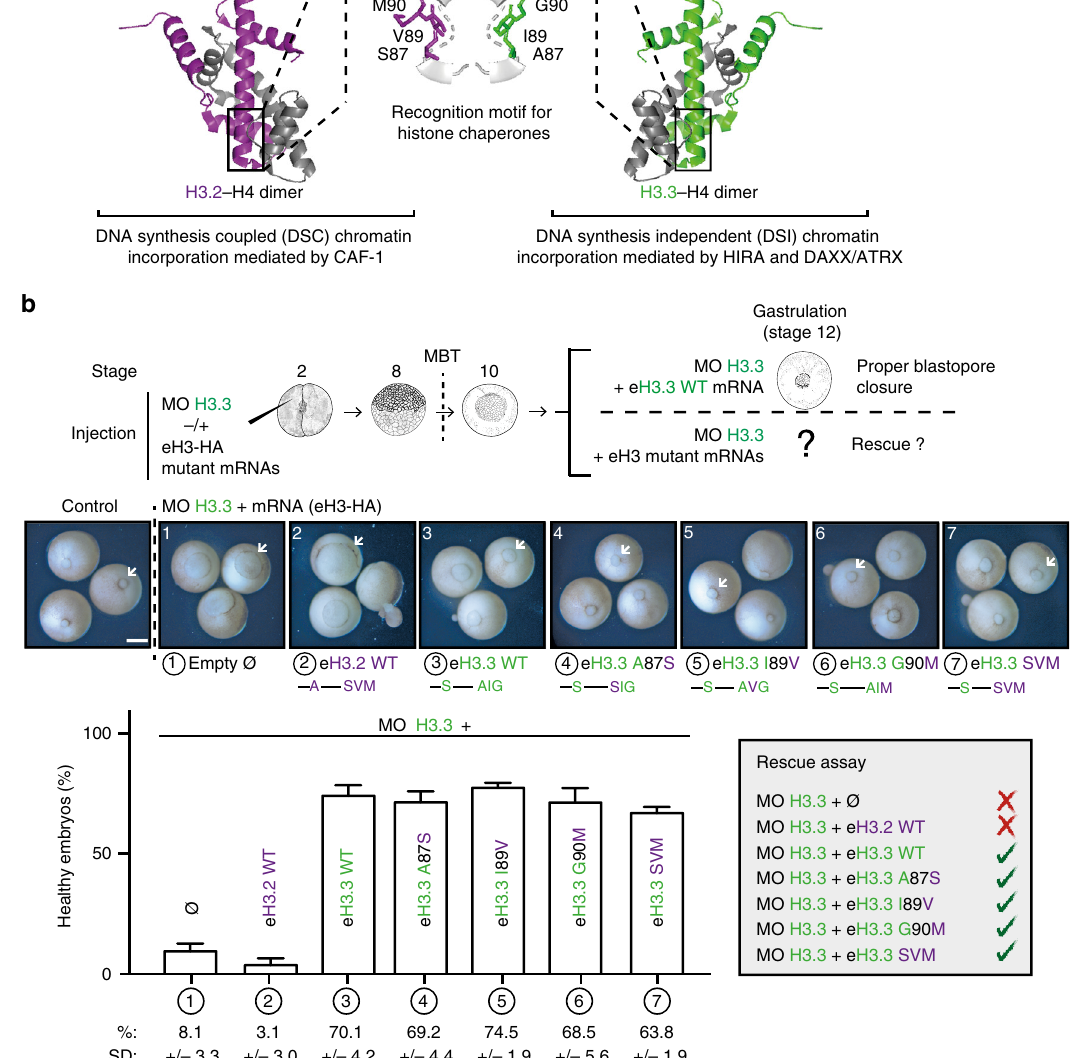
Fig. 2 eH3.3 AIG mutants rescue depletion of H3.3 during X. laevis early development. a Highlights of the histone chaperone recognition motif residues of H3 variants. Dedicated histone chaperones recognize histone variants by the H3.2 SVM and H3.3 AIG motifs. Although both motifs are structurally similar, the main difference appears for the residue 90. Crystal structures adapted from PDB ID codes 5B0Z 105 and 3 AV2 9 . b Rescue assays with H3.3 AIG mutants. Injections are performed at two-cell stage. Effect on gastrulation is analyzed at stage 12. White arrowheads indicate the blastopore closure. Scale bar corresponds to 500 µ m. Bar plot shows mean ± SD for three independent experiments with more than 30 embryos. Source data are provided as a Source Data fi